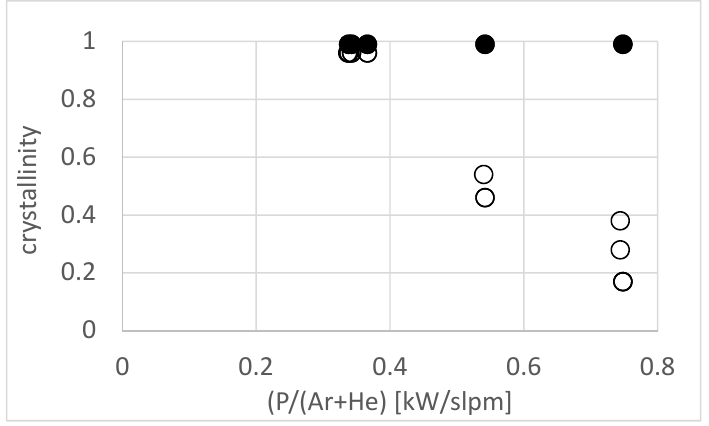
Figure 5. Degree of crystallinity of the as-sprayed (open symbols) and heat-treated (100 h, 1300 °C, closed symbols) coatings as a function of the power normalised to the total gas flow for different substrates .